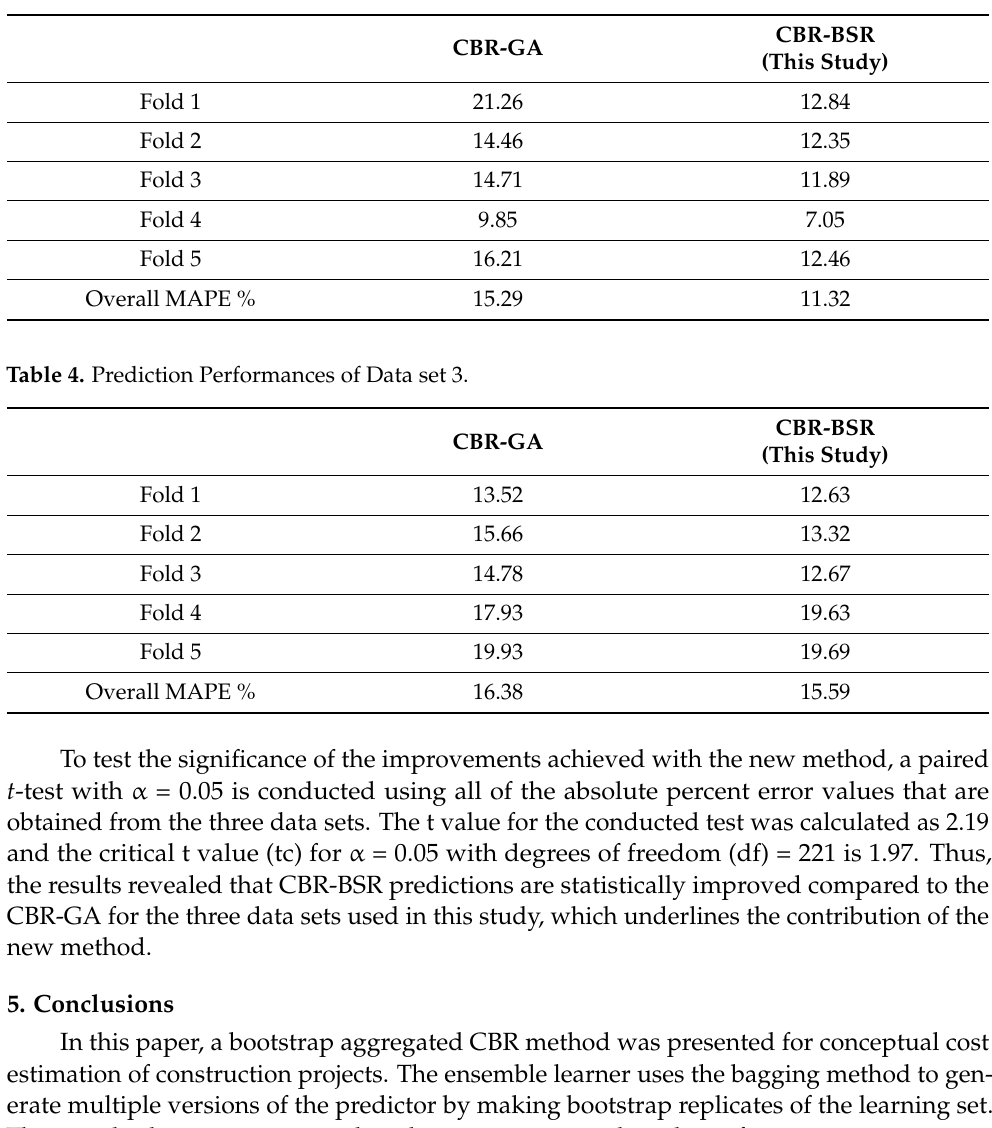
Table 3. MAPE % Performances of Data set 2.